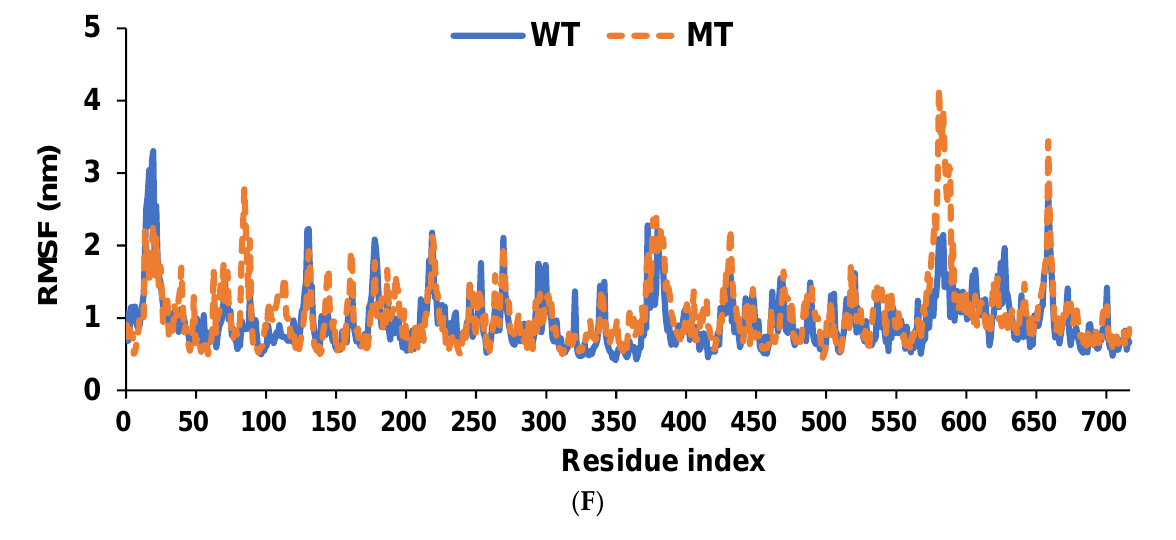
Figure 4. Molecular docking and molecular dynamic simulation (MDS) of rugosin A on growth differentiation factor-5 ( GDF-5 ) rs224331 (Ala276Ser) wild and mutated types. ( A ) Molecular docking of rugosin A on GDF5 rs224331 wild type. ( B ) The interaction force between rugosin A on GDF5 rs224331 wild type. ( C ) Molecular docking of rugosin A on GDF5 rs224331 mutated type. ( D ) The interaction force between rugosin A on GDF5 rs224331 mutated type. ( E ) RMSD of rugosin A on GDF5 rs224331 wild and mutated types. ( F ) RMSF of rugosin A on GDF5 rs224331 wild and mutated types.